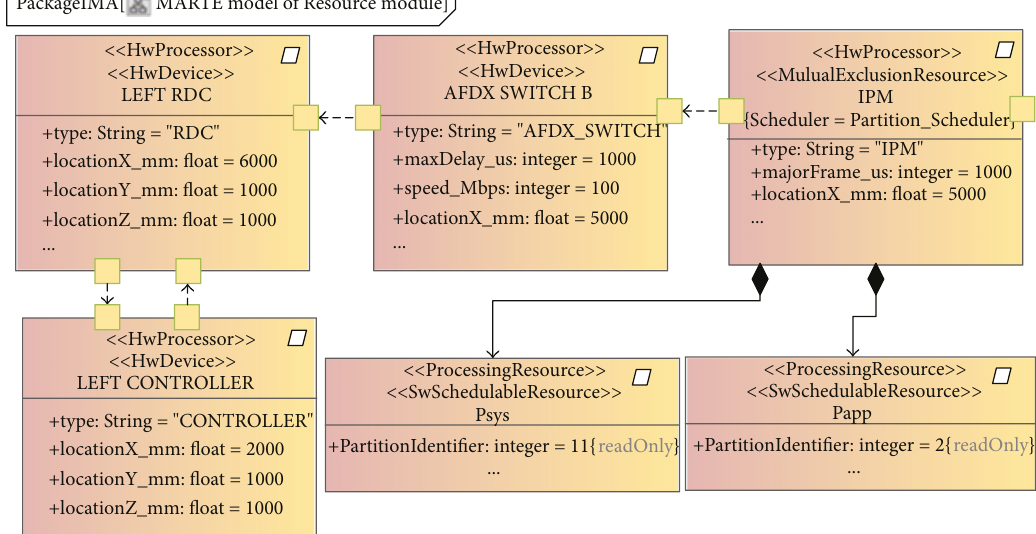
Figure 9: MARTE model of resource module.